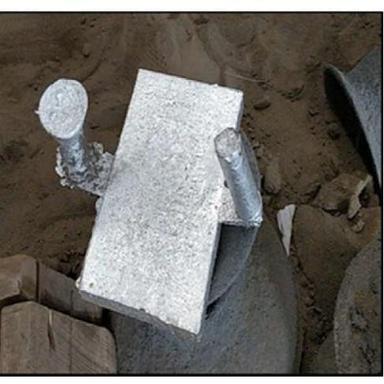
Prepared NMMC.